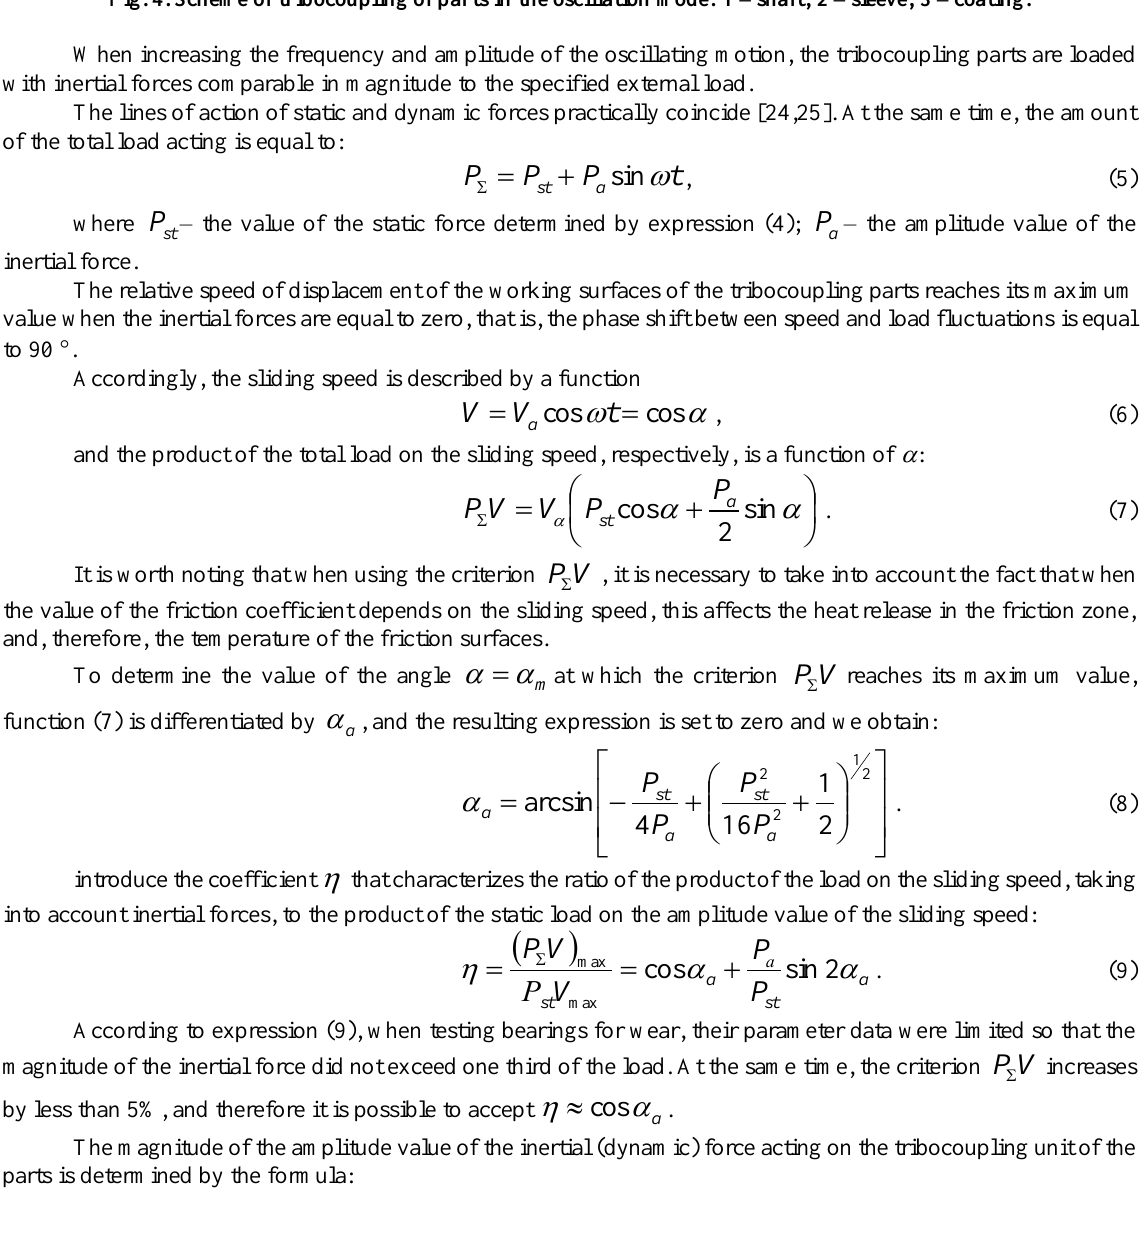
Fig. 4. Scheme of tribocoupling of parts in the oscillation mode: 1 – shaft; 2 – sleeve; 3 –